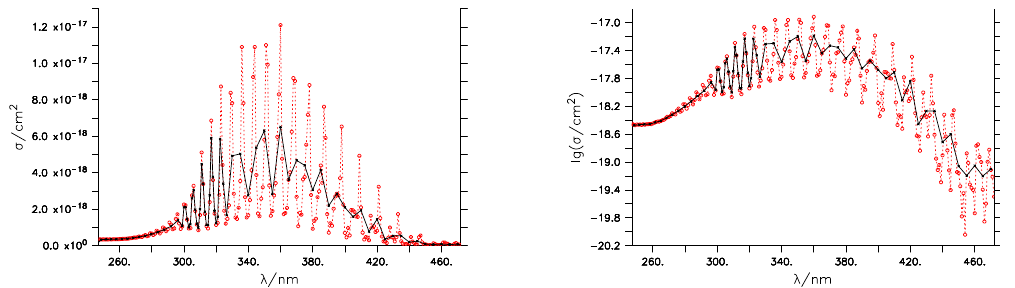
Figure 1. Absorption cross sections of OClO on a linear (left) and logarithmic (right) scale. The red line shows the original data taken from Sander et al. (2011b) and the black line after interpolation by JVPP to a fixed grid of 176 wavelengths.